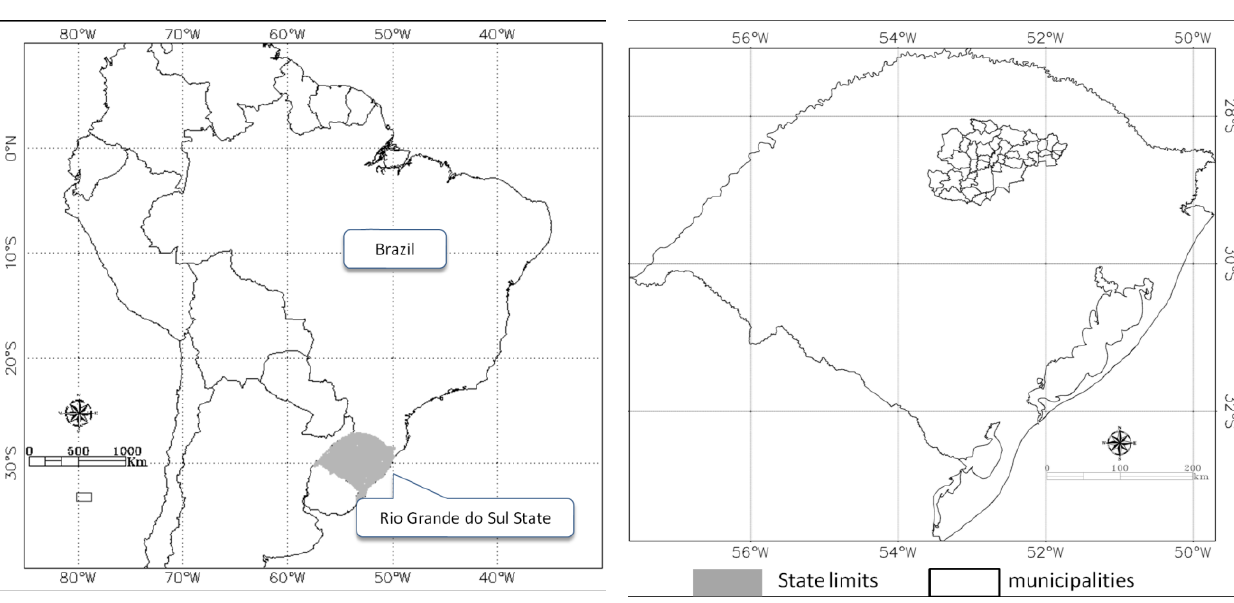
Figure 1. Rio Grande do Sul State, Brazil, and the 39 municipalities